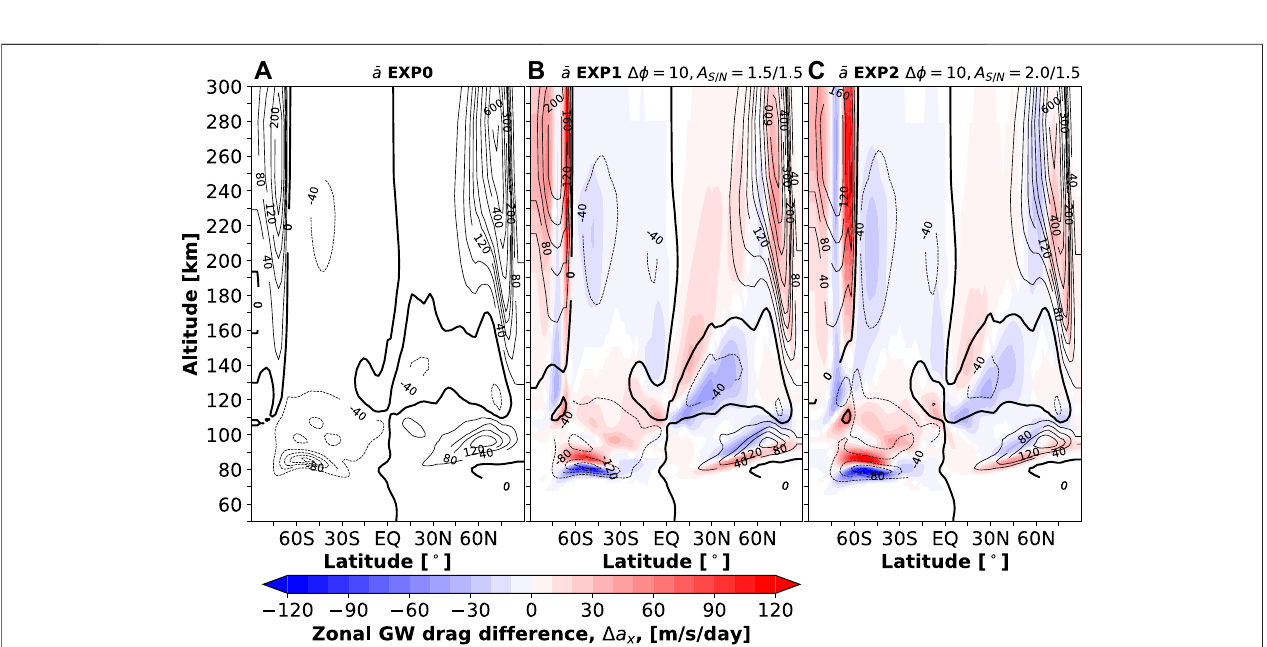
FIGURE5| sameasin Figures4A – C ,butforthezonalmeanGWdrag.Thecontourintervalsare40 ms − 1 day − 1 between ± 200ms − 1 day − 1 and100 ms − 1 day − 1 for the drag values with magnitudes larger than 200 m s − 1 day − 1